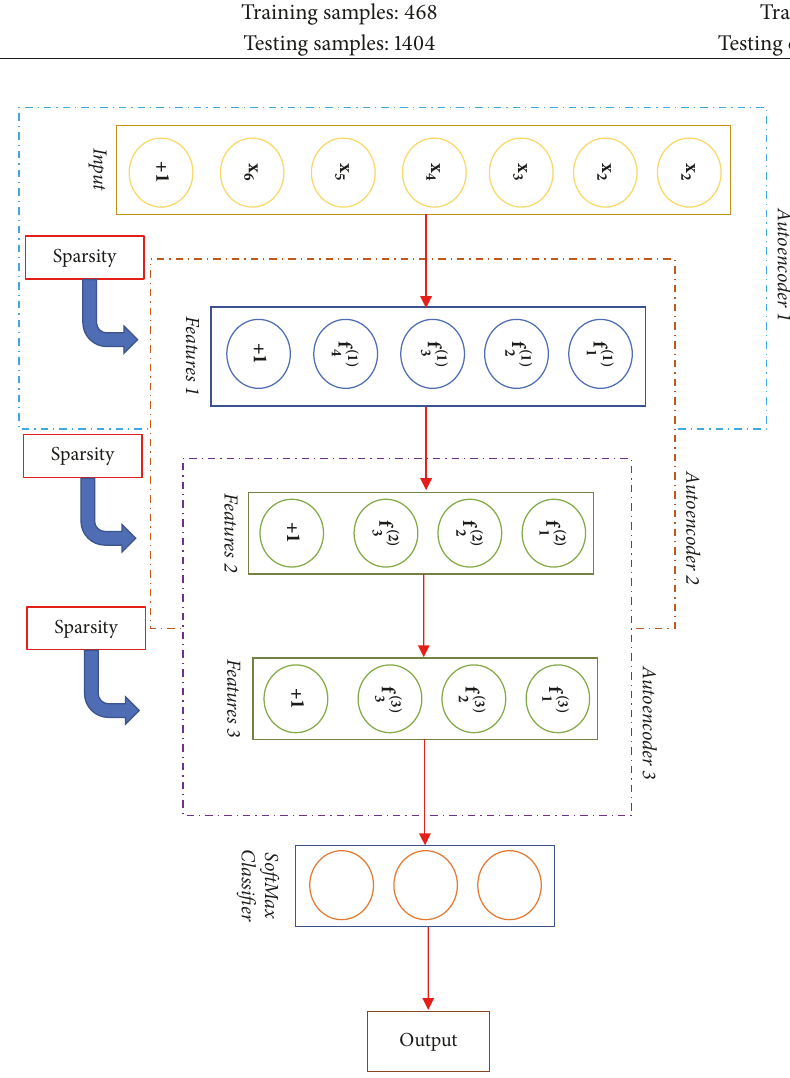
Figure 3: A schematic diagram of the three-layered SSAE-based